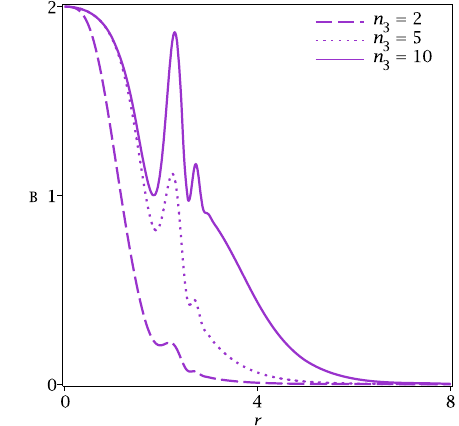
Fig. 14 Magnetic inductions B 3 ( r ) for a symmetric BPS solution with permeabilities μ 1 = 1, μ 2 = | ϕ 1 | 2 and μ 3 given by Eq. (30). Results are shown for three values of n 3 , namely n 3 = 2, n 3 = 5 and n 3 =